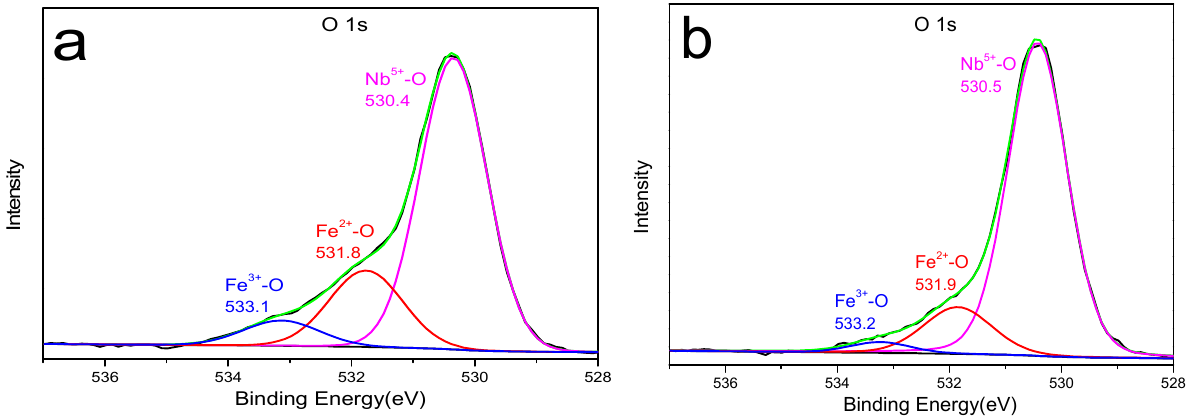
Figure 9. High-resolution XPS spectra of O 1s of the FeNb 2 O 6 after different concentrations of HF leaching: ( a ) 5mol/L HF; ( b ) 10mol/L HF.